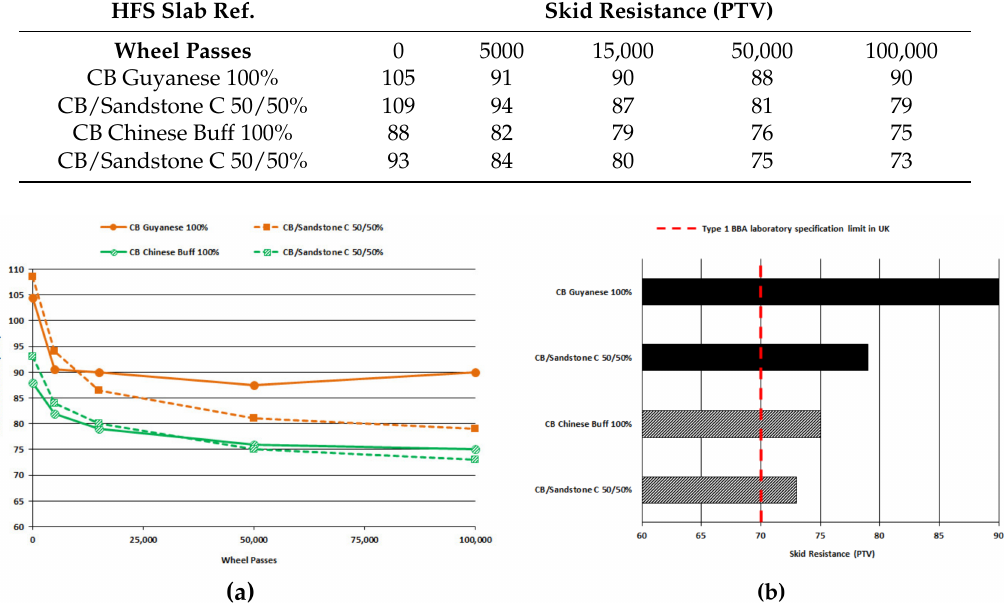
Table 6. Skid resistance data (Ulster University data). HFS Slab Ref.